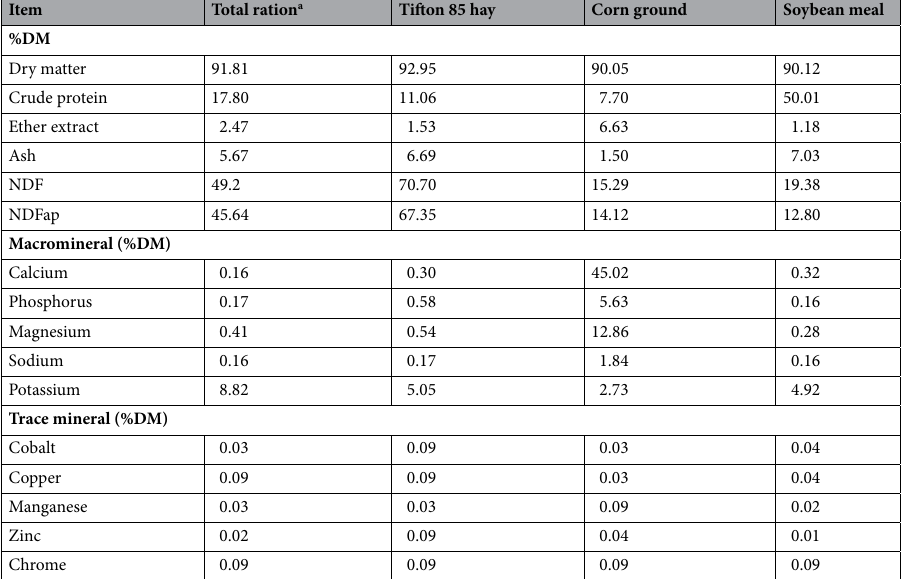
Table 1. Chemical composition (%) of feedstuffs and experimental diet. DM dry matter, NDFap neutral detergent fiber corrected for ash and protein, NDF neutral detergent fiber. a Total ration with ingredient proportions of the total ration (g/kg as fed): Tifton 85 hay (60%); ground corn (20.07%); soybean meal (19.23%); limestone (0.19%); dicalcium phosphate (0.41%); sodium chloride (0.07%) and mineral premix (0.03%). Composition of mineral premix (1 kg of premix): calcium, 225 g to 215 g; phosphorus, 40 g; sulfur, 15 g; sodium, 50 g; magnesium, 10 g; cobalt, 11 mg; iodine, 34 mg; manganese, 1800 mg; selenium, 10 mg; zinc, 2000 mg; iron, 1250 mg; copper, 120 mg; fluor, 400 mg; vitamin A, 37.5 mg; vitamin D3, 0.5 mg; and vitamin E, 800